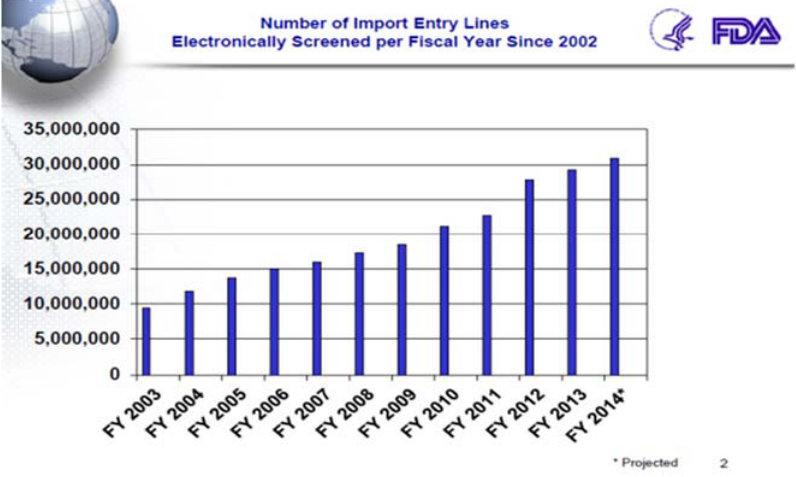
Figure 2. Number of USFDA Import Entry Lines.